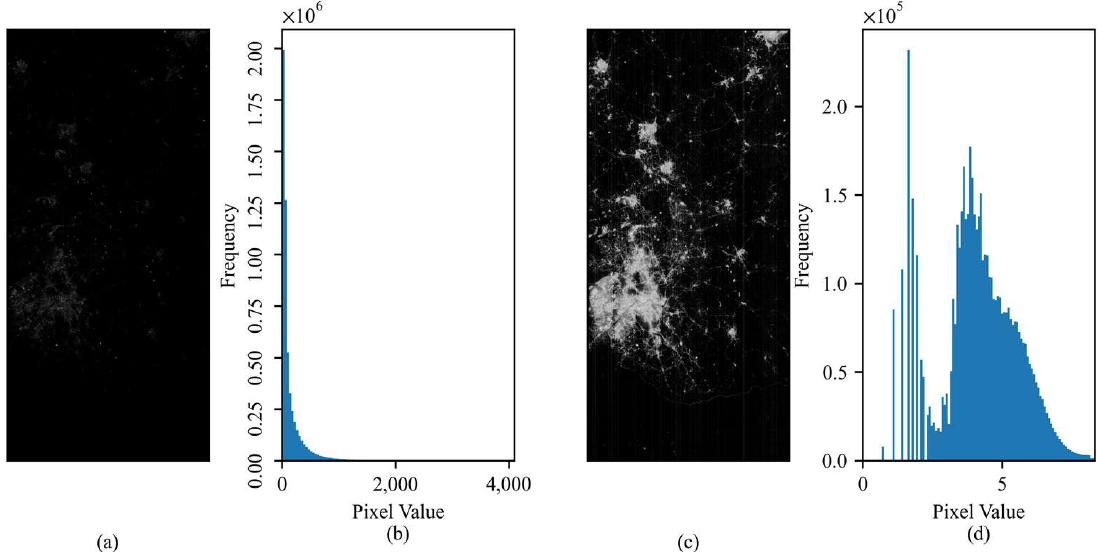
Figure 2. Comparison before and after image contrast enhancement. ( a ) Raw image; ( b ) the histogram of raw image; ( c ) contrast enhanced image; ( d ) the histogram of contrast enhanced image. The frequency of 0 is too high, which will affect the readability of the histogram, and we ignored 0 when drawing the histogram.